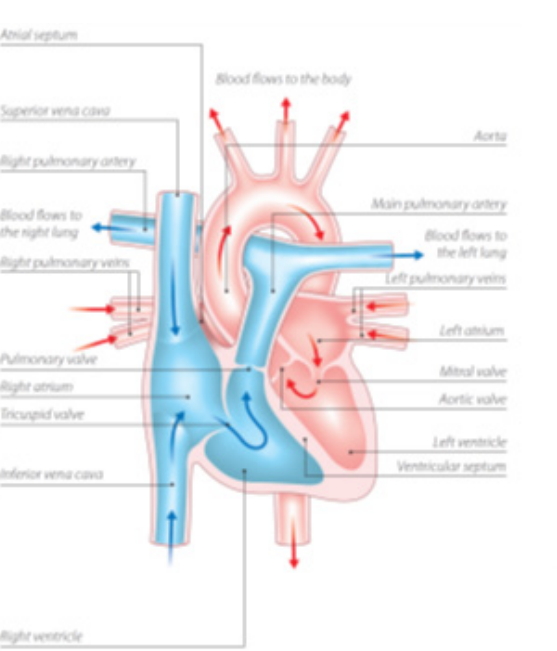
Figure 1a. Normal Heart; 1. Understanding your child's heart - Dou- ble inlet ventricle (British Heart Association. 1st ed. 2016. Cited 28 November 2016. Available from: https://www.bhf.org.uk/pu- blications/children-and-young-people/understanding-your-childs- heart---double-inlet-ventricle) Reprinted with permission from British Heart Association